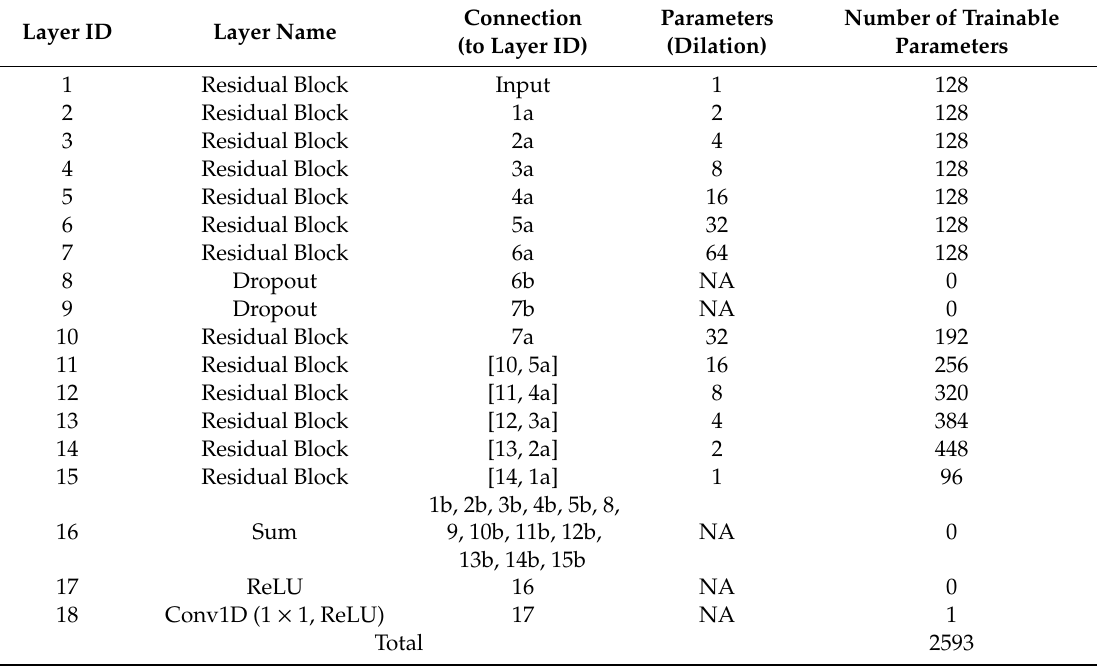
Table 5. ResUnet